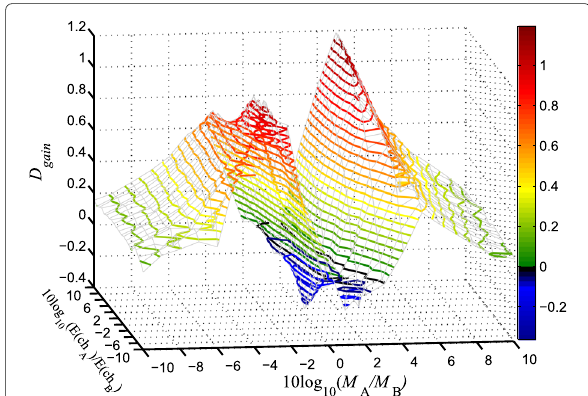
Fig. 13 The 3D contour of the delay gain achieved by the proposed scheme